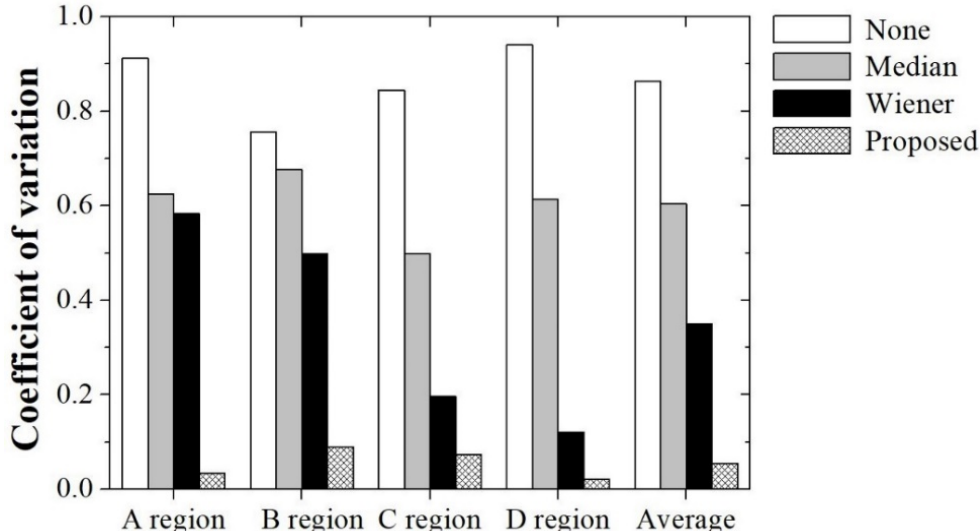
Figure 4. Experimental results for the coefficient of variation (COV) factors of the segmentation image under four conditions: none ( ① ), the median filter ( ② ), the Wiener filter ( ③ ), and the proposed filter ( ④ ). The COV was calculated for the specified regions A to D in the yellow ‐ box regions in Figure 3. The regions of interest (ROIs) were set as boxes A to D because these parts quantitatively determined the amount of additional noise relative to the manicured vein. The average COV factors of image ‐ processing methods ① to ④ were 0.86, 0.60, 0.35, and 0.05, respec ‐ tively.